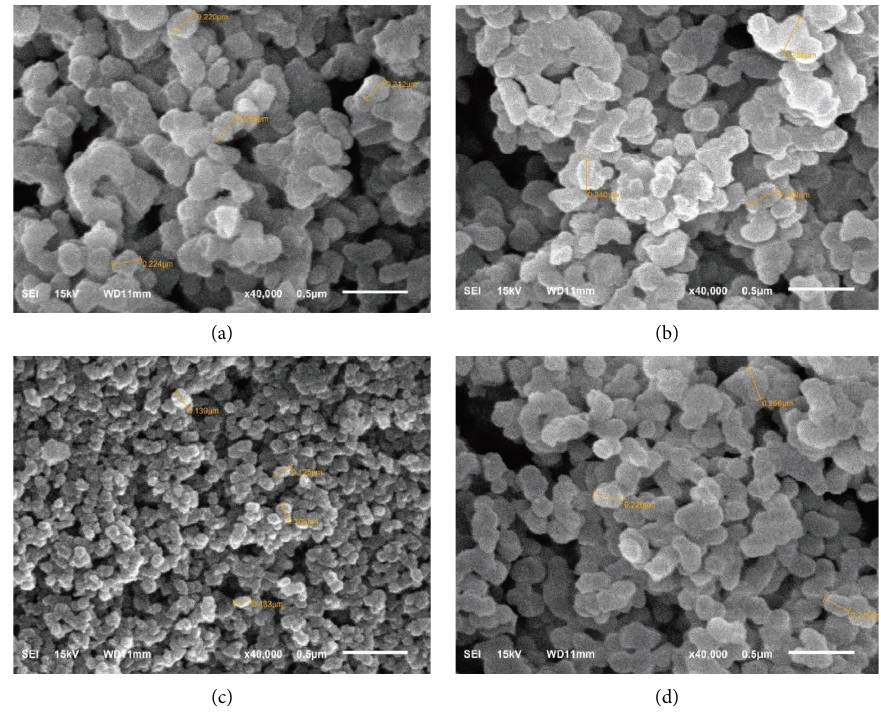
Figure 3: Te morphology of MIPMS and NIPMS using SEM: (a) MIPMS-1, (b) NIPMS-1, (c) MIPMS-2, and (d)